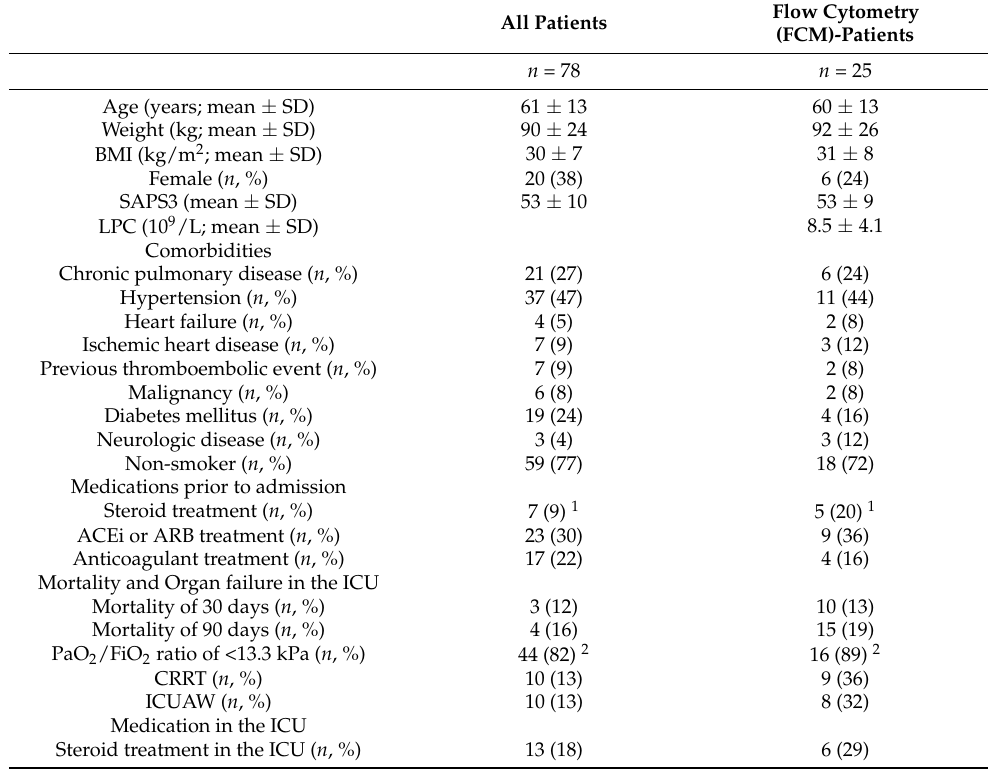
Table 1. Demographic and clinical